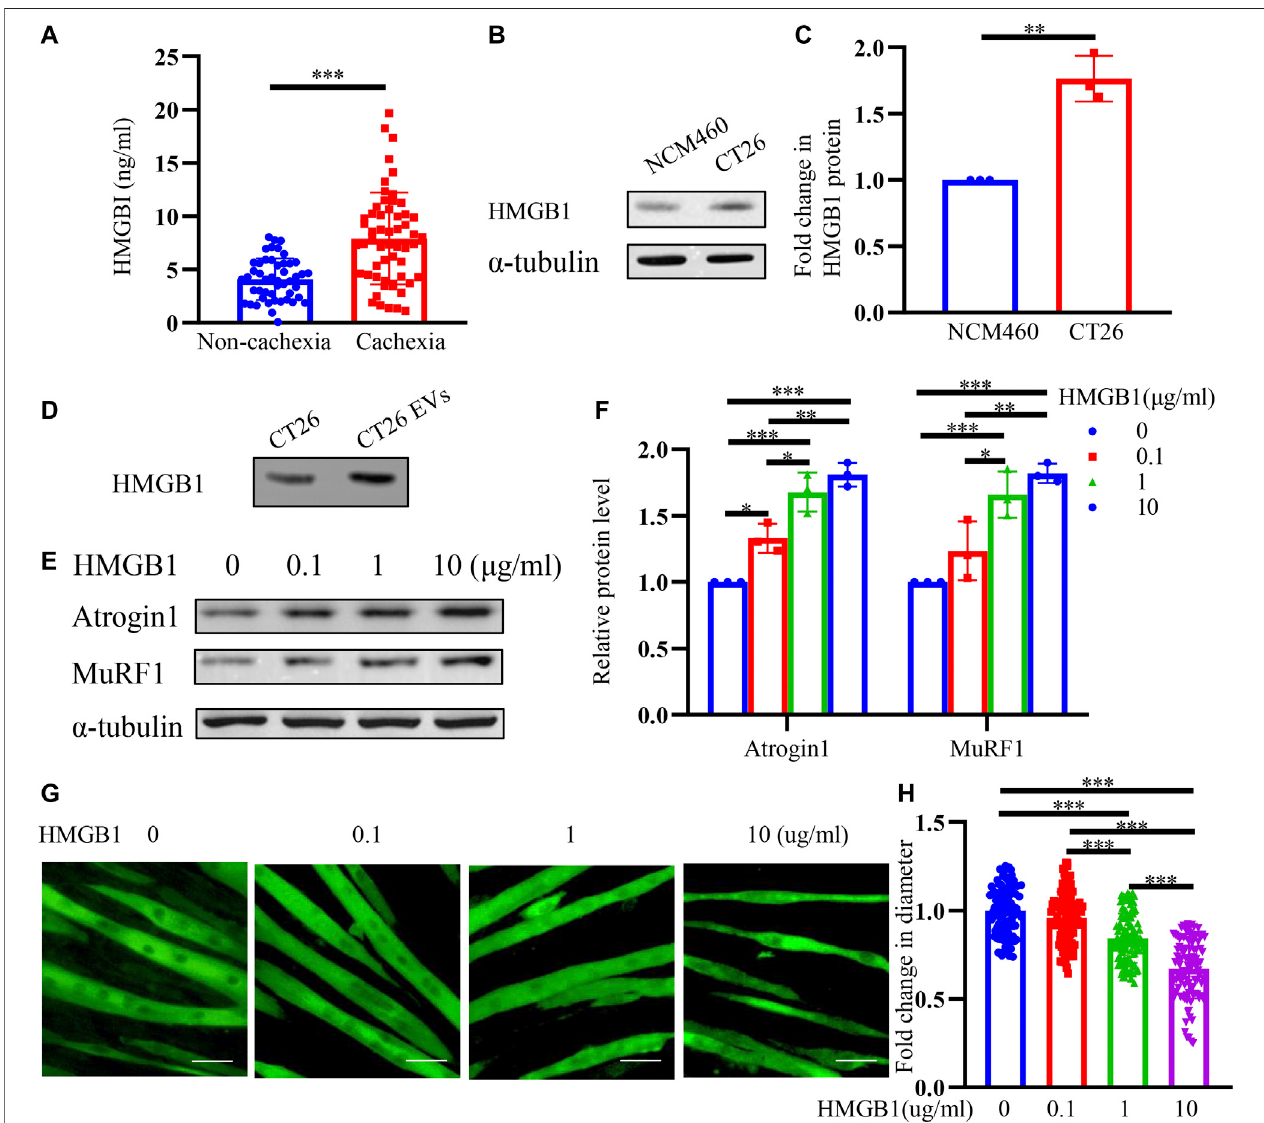
FIGURE 3 | HMGB1 is upregulated in CT26-derived exosomes and HMGB1 induces muscle wasting in vitro . (A) The serum HMGB1 in colon cancer cachexia patients was higher than non-cachexia patients. (B) HMGB1 expression was higher in CT26 cells than normal colonic epithelium (NCM460 cells). (C) Densitometric quanti fi cationofthe HMGB1 signal relative tothe α -tubulinsignal. (D) CT26-EVscontained high level ofHMGB1 protein. (E) Total extractsofC2C12 myotubestreated with differentconcentrationsofrecombinantHMGB1wereusedfor westernblottinganalysiswithantibodiesagainstwithAtrogin1,MuRF1and α -tubulin. (F) Densitometric quanti fi cation of the Atrogin1 and MuRF1 signal relative to the α -tubulin signal. (G) Representative immuno fl uorescence images for C2C12 myotubes treated with different concentrationsofrecombinant HMGB1. Scale bar (cid:2) 50 μ m. (H) The relative fi ber widths ofC2C12 myotubes treated withdifferent concentrations ofrecombinant HMGB1.